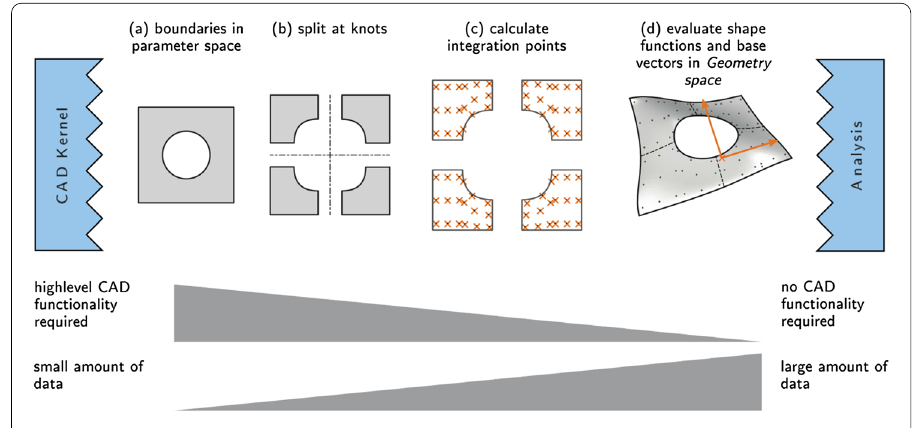
Fig. 9 Preparation of a trimmed surface for IBRA. Each step requires complex geometric functions. These functionalities can either be assigned to the CAD software or to the analysis tool. The complexity of the geometric requirements decrease to the right whereas the amount of data at the interface